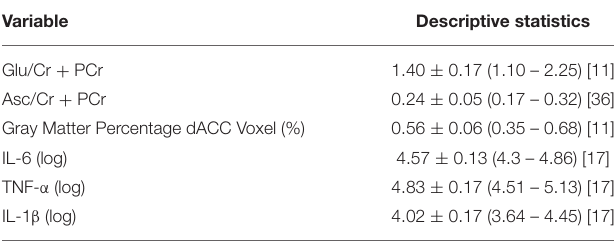
TABLE 2 | Descriptive statistics for main variables of interest.